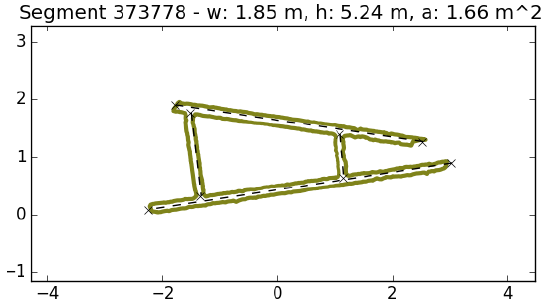
Figure 6: Linear sub-segments (dashed lines) of a non-linear